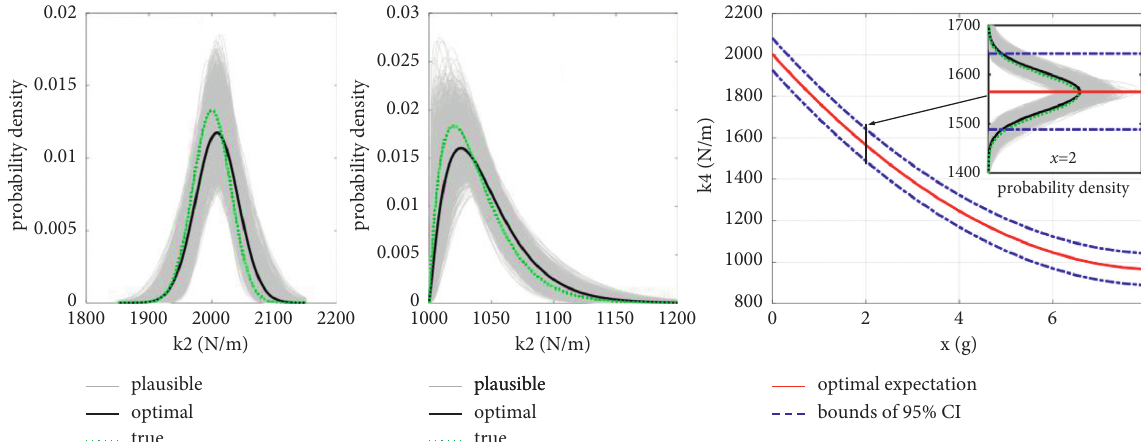
Figure 15: Identification results of PDFs for equivalent spring stiffness. Plausible PDFs are plotted with grey lines, and the optimal PDF is plotted with black lines.